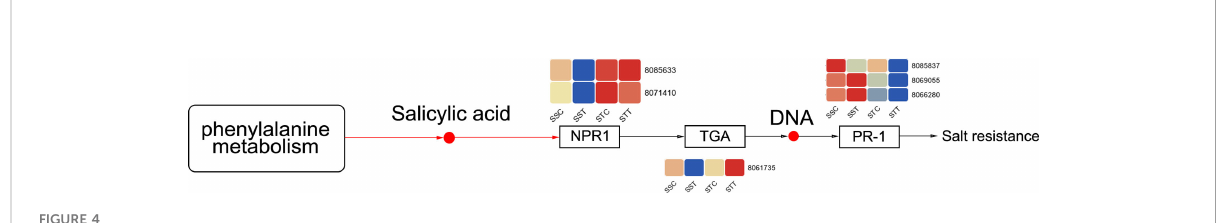
FIGURE 4 Differently expressed genes (DEGs) in the salicylic acid signal pathway. The redder the circle, the higher the expression. STC: LRNK1-Control, STT: LRNK1-Salt treatment, SSC: LR2381-Control, SST: LR2381-Salt treatment.